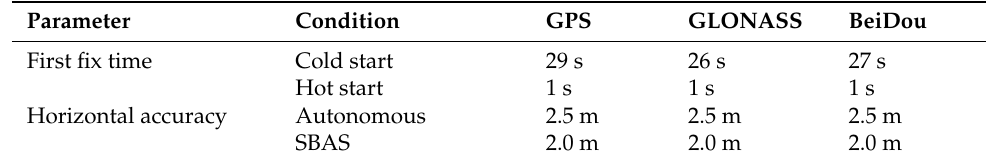
Table 2. Neo M8N first fix and horizontal accuracy.